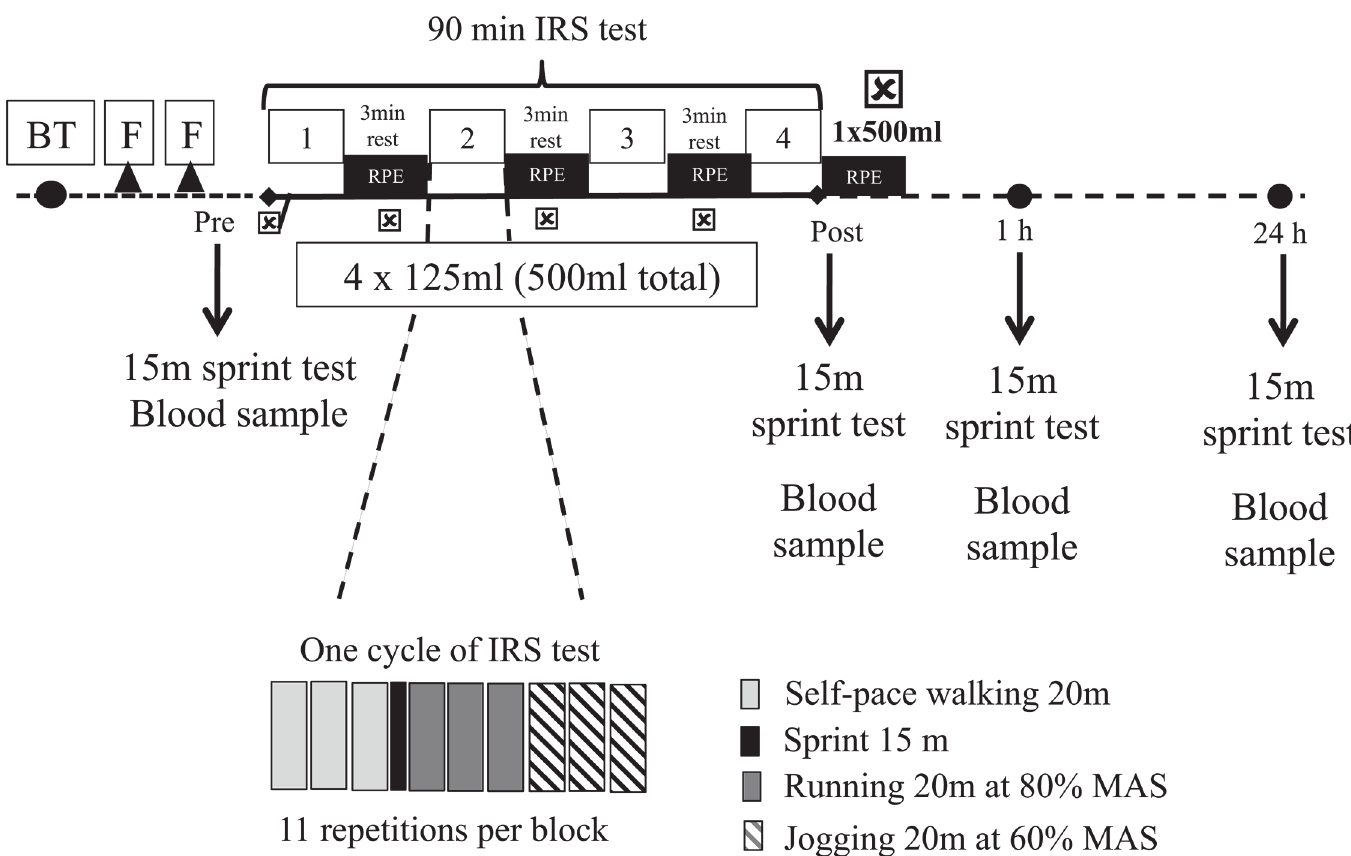
Fig 1. Schematic overview of the study design. BT beep test; F, familiarization Sessions, ☒ MTN, CHO, or PL ingestion; 90 min IRS test: intermittent repeated sprint test involving 4 blocks of 11 cycles of 3 repetitions of 20 m at 60%; one 15m sprint; 3 repetitions of 20 m at 80%, and at 60% maximal aerobic speed; RPE: determination of the rate of perceived exertion value from the 6 – 20 Borg scale points; 15m: sprint test; Blood: blood extraction from the cubital